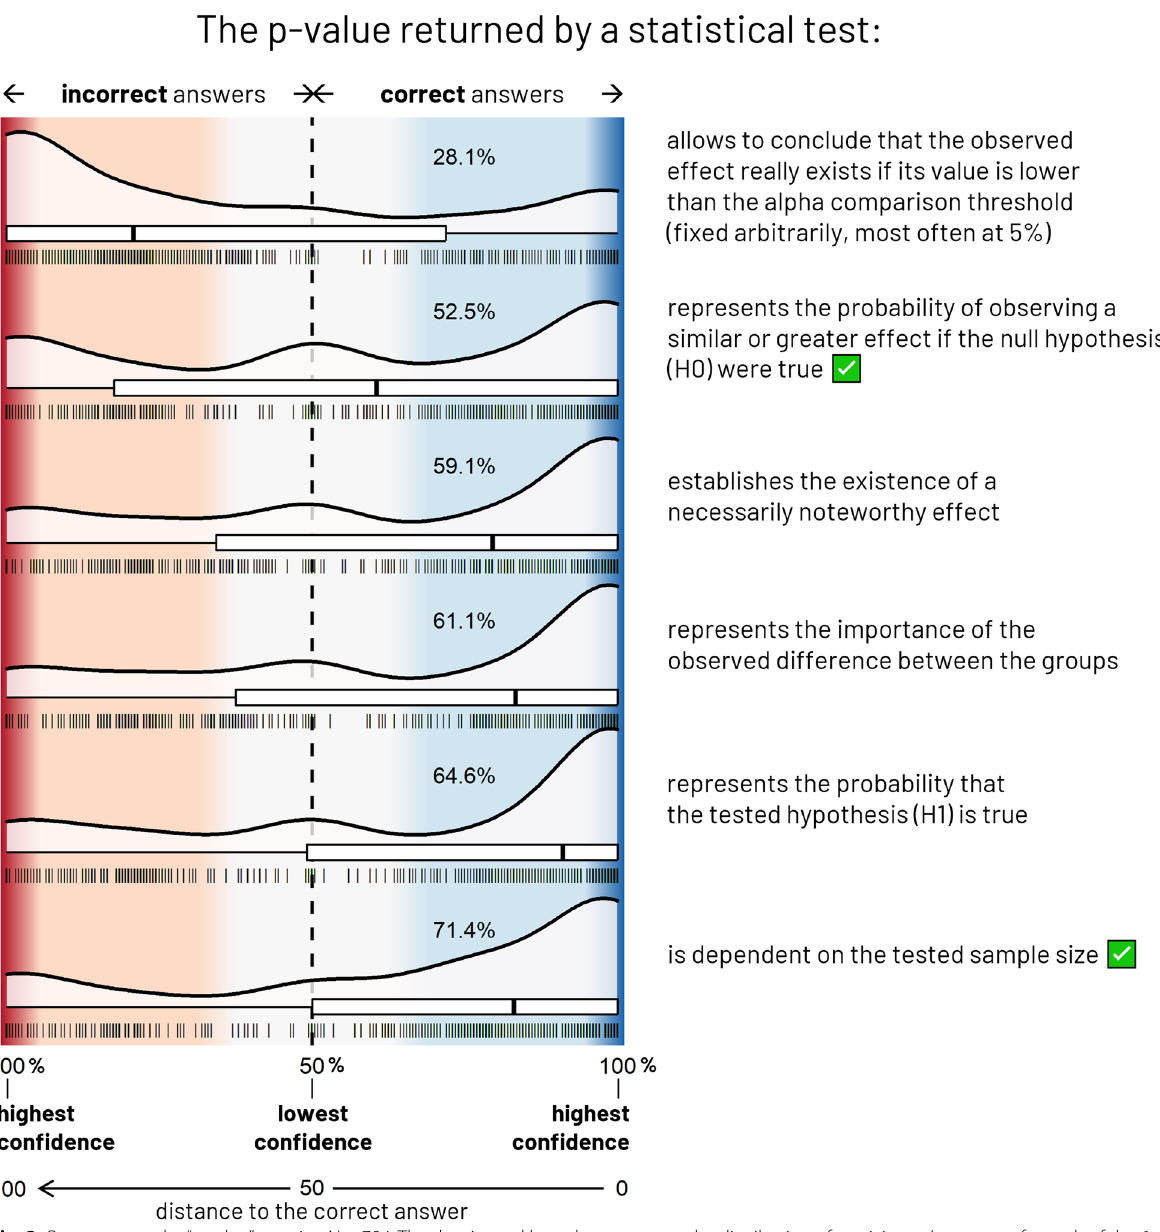
Fig. 3 Responses to the “ p value” exercise, N 794. The density and box plots represent the distribution of participants’ responses for each of the 6 = proposed claims. The collected data are here mapped onto a double‑sided probability scale ranging from 50% (lowest confidence, the participant answered randomly) to 100% (maximal confidence judgment), both for correct (blue area) and incorrect (red area) answers. Also represented on the x‑axis, the distance to the correct answer (d) is defined as a score composed both by the accuracy and confidence, ranging from 0: correct answer with maximal confidence to 100: incorrect answer with maximal confidence through 50: “I do not know”, d < 50 and d > 50, respectively, corresponding to correct and incorrect answers. Each vertical line stands for a response. The percentage of this exercise’s participants who gave a correct answer is indicated in each blue area. True claims are indicated by a green ticked